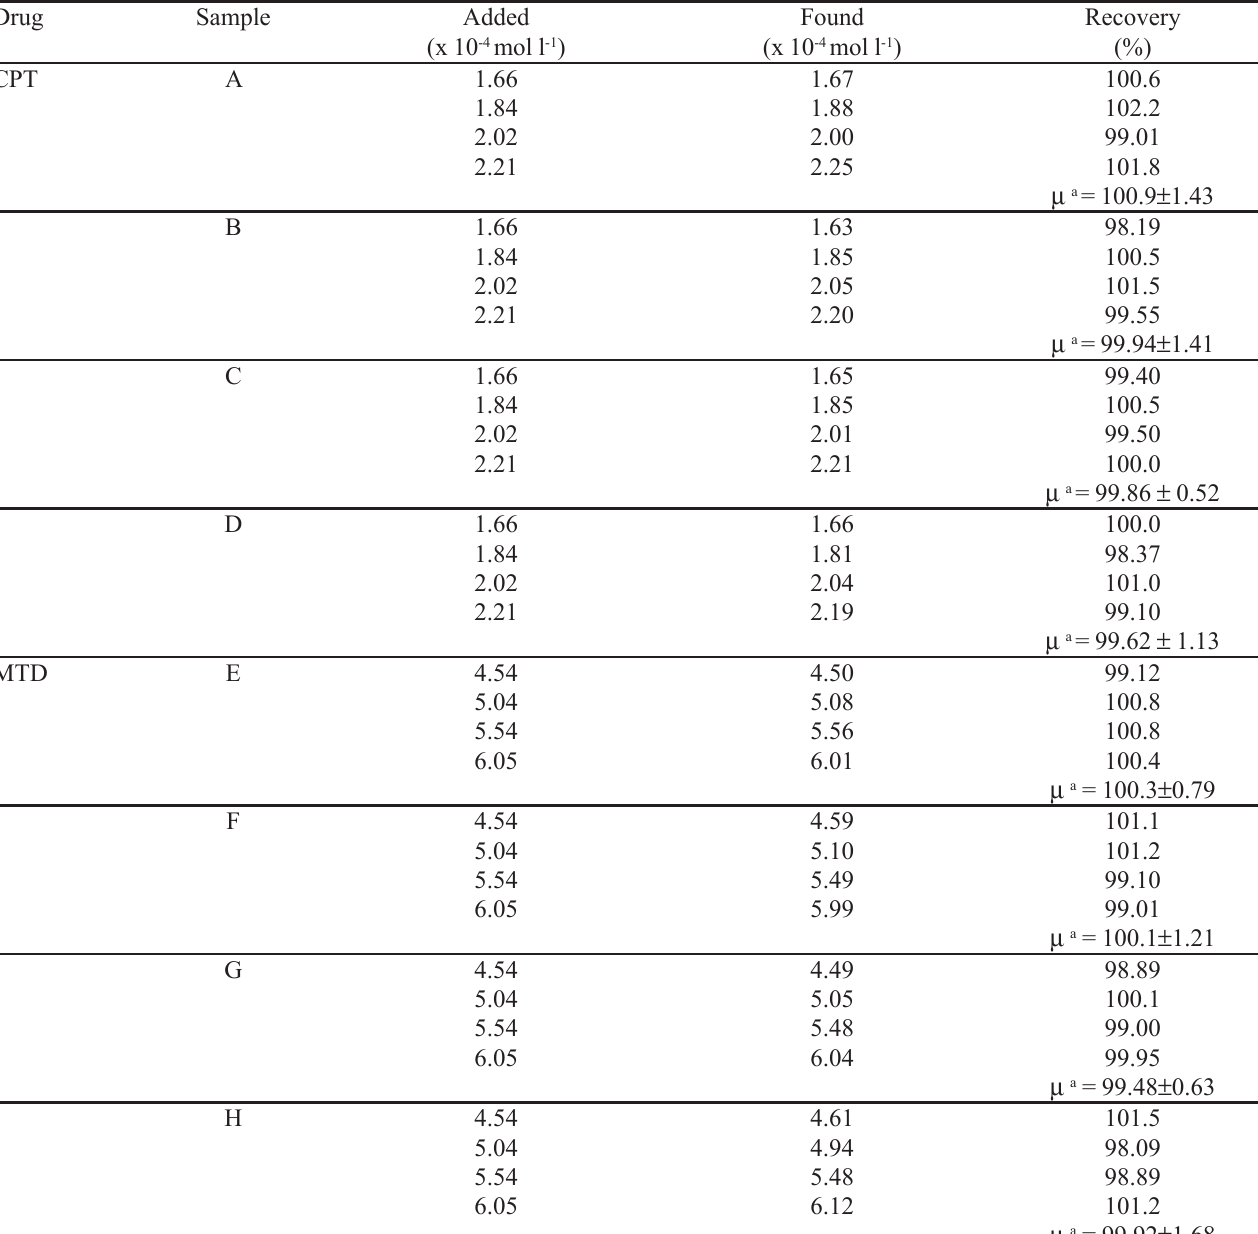
TABLE II - Recovery study data for CPT and MTD using proposed device Drug